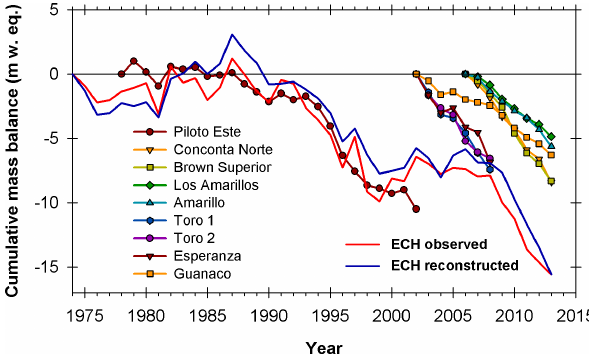
Figure 5. Comparison between the cumulative patterns in the ob- served and reconstructed records from ECH and other glaciers with available direct mass-balance data in the Dry Andes of Chile and Argentina (Fig. 1 and Table